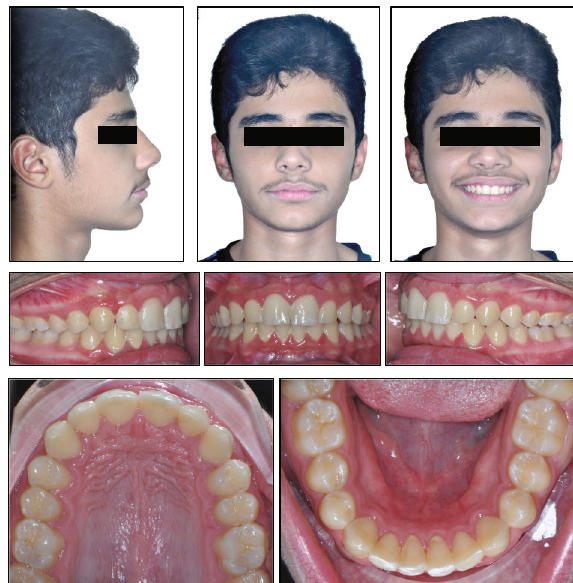
Figure 9: 1-year follow-up facial and intraoral photographs.